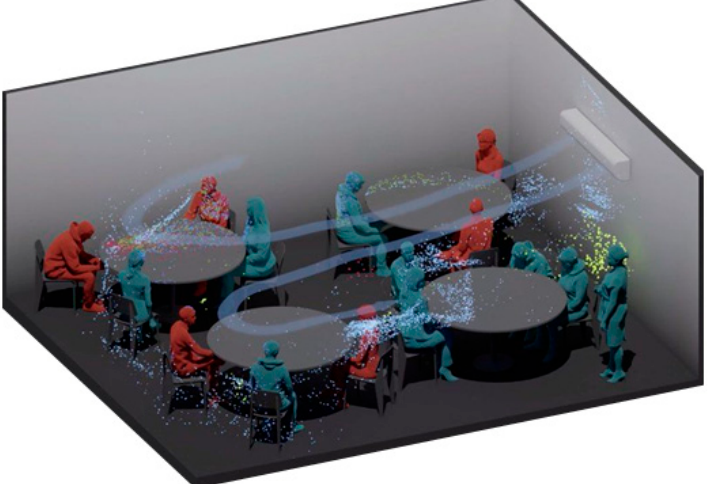
Figure 8. Minimum recommended clearance of patient corridor design (Adapted from [73]).